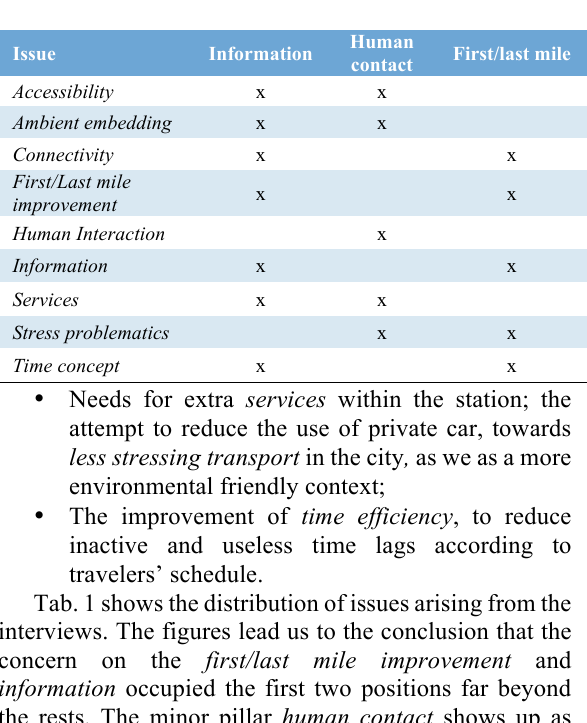
Tab. 2. Pillar-interview connection.